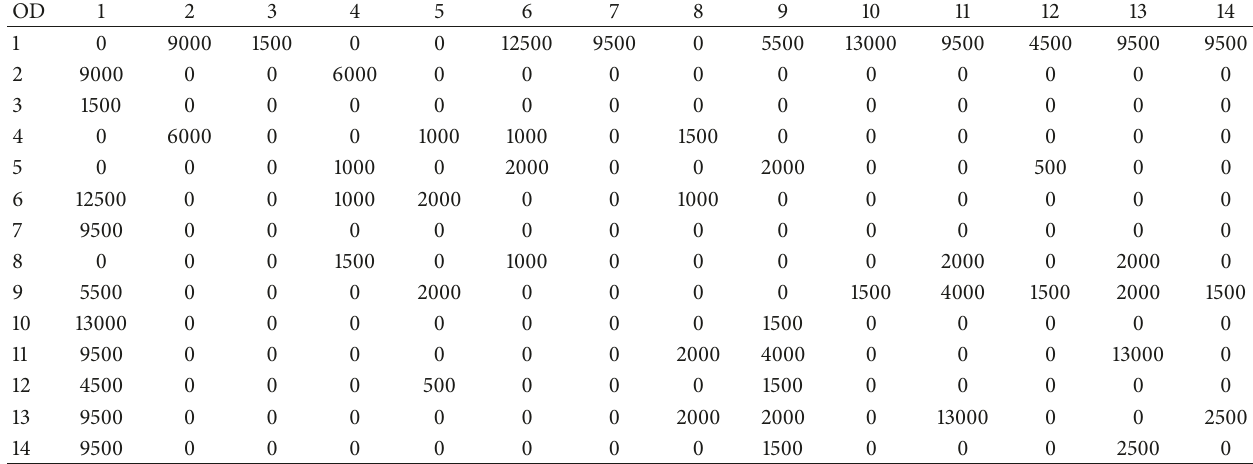
Table 5: Service capacity in each OD pair (items).